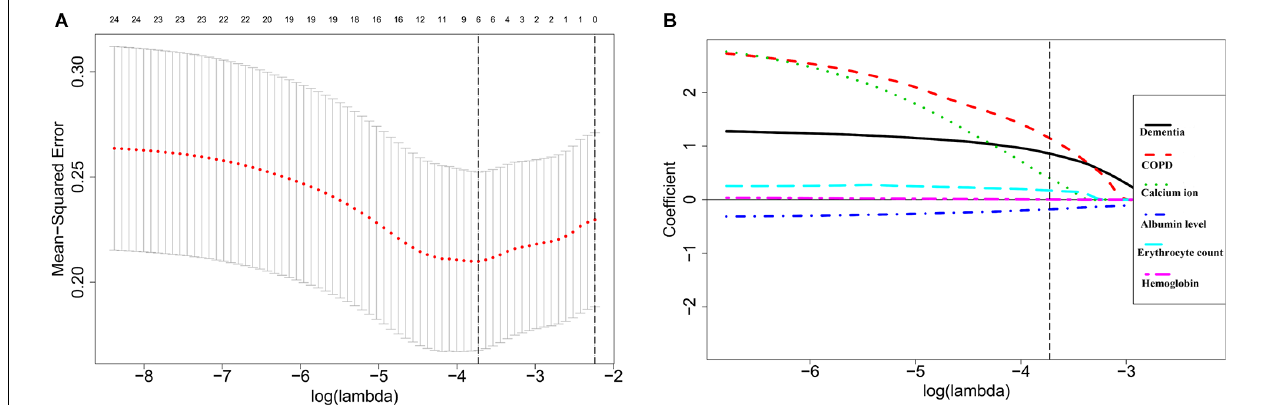
FIGURE 1 | Selection of feature variables using the least absolute shrinkage and selection operator (LASSO) regression analysis. (A) Cross-validation for the feature variable selection of optimal lambda value in the LASSO model. The left and right dotted vertical lines represent the values of log (lambda.min) and log (lambda.1se). (B) LASSO coefficient profiles of the six feature variables. The dotted vertical line represents the value of log (lambda.min).